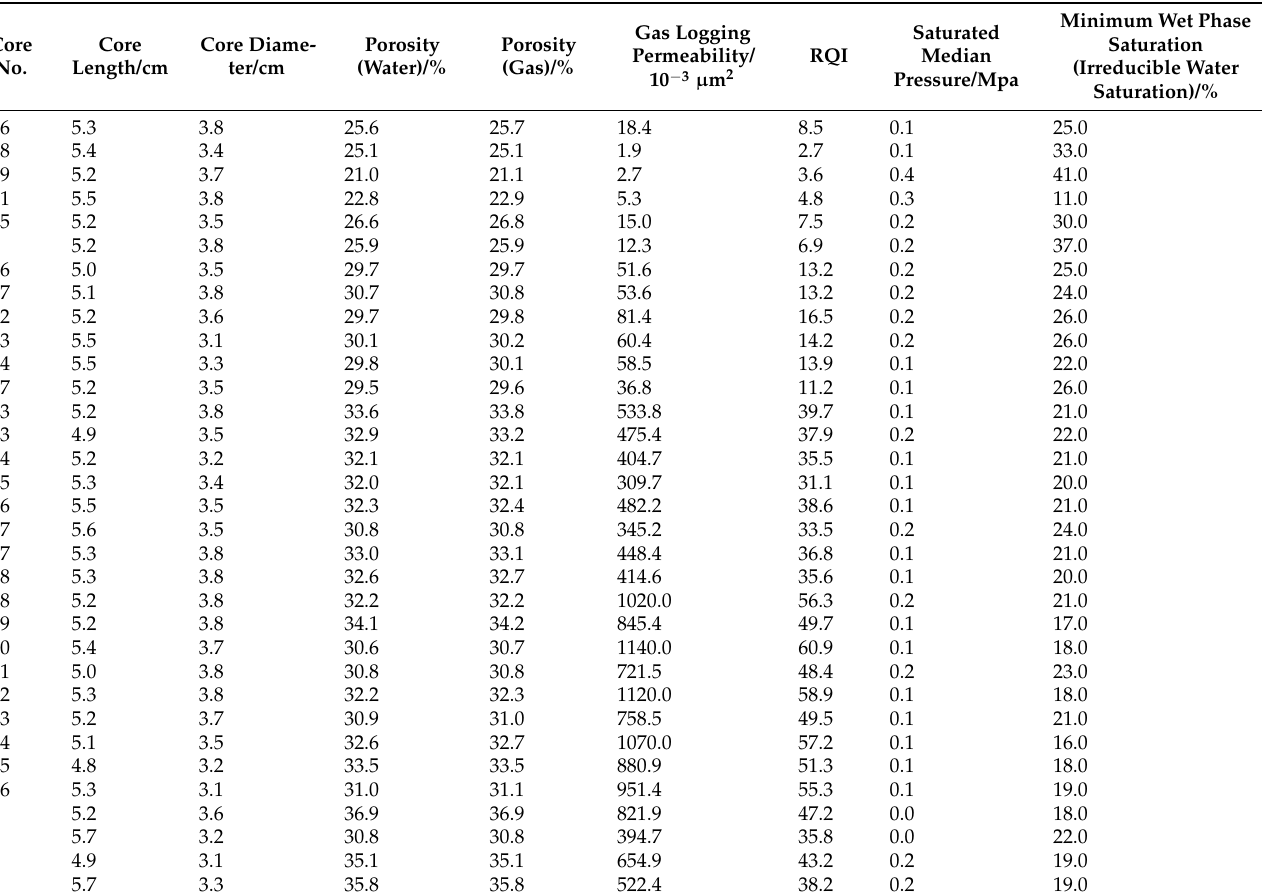
Table 1. Capillary pressure test data of P Formation core samples.